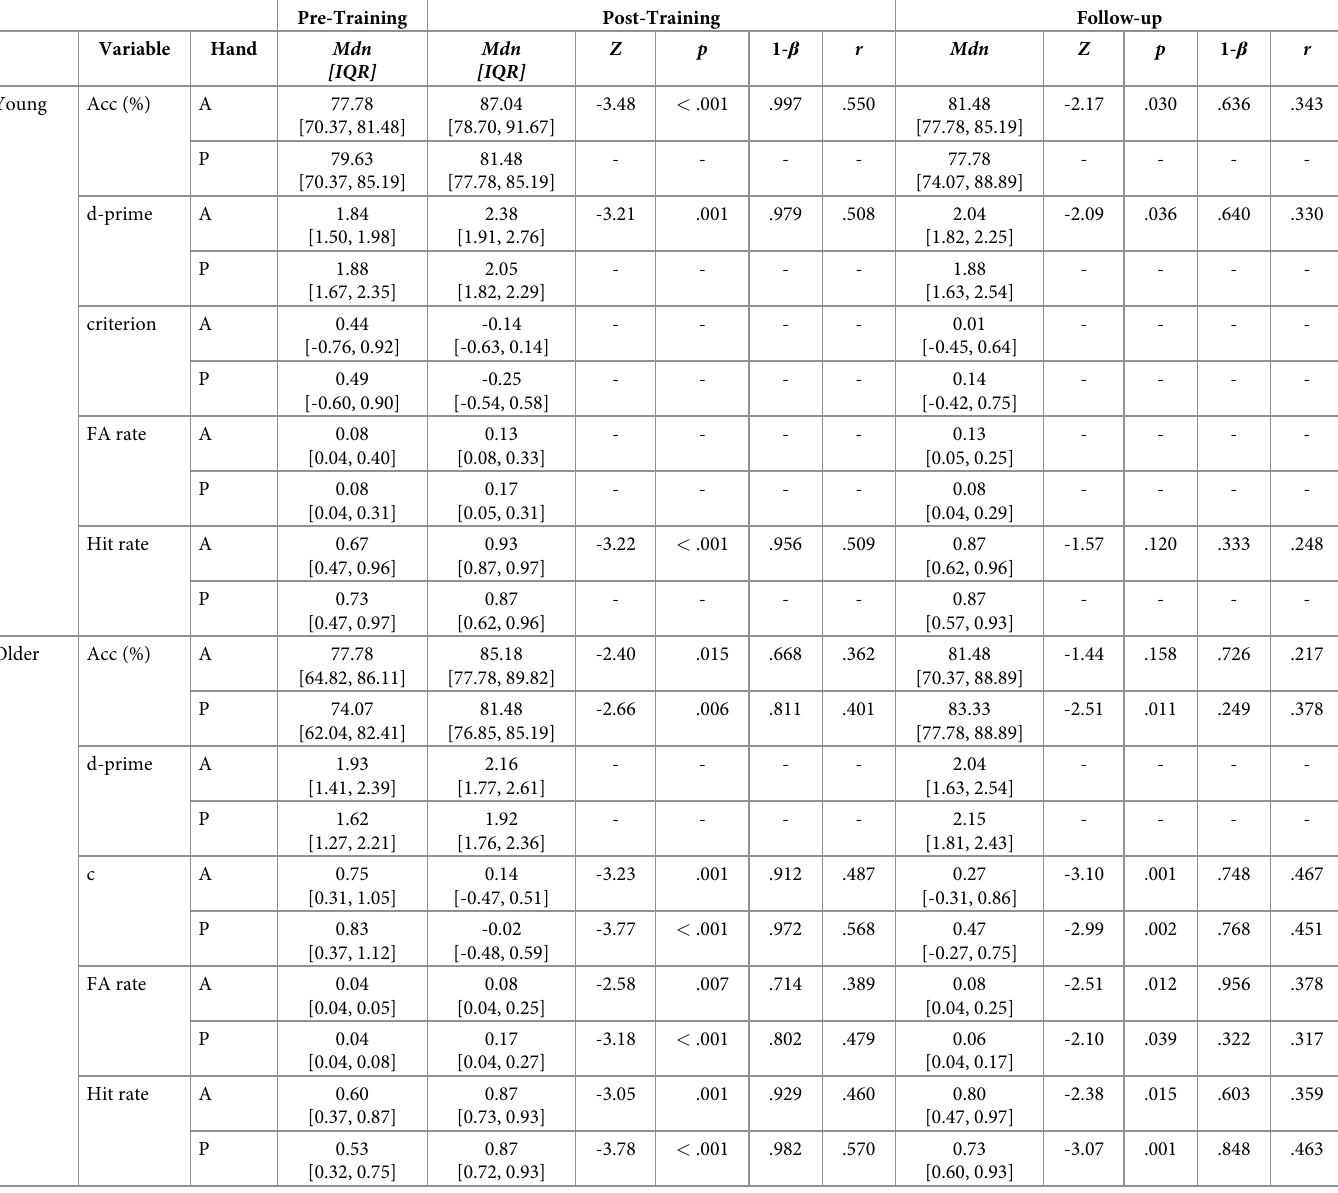
Table 2. Descriptive data for young and older adults as well as post-hoc analyses comparing pre-training performance with post-training as well as follow-up perfor- mance (Wilcoxon-Tests, only listed for variables with a significant effect of session indicated by Friedman. Pre-Training Post-Training Follow-up